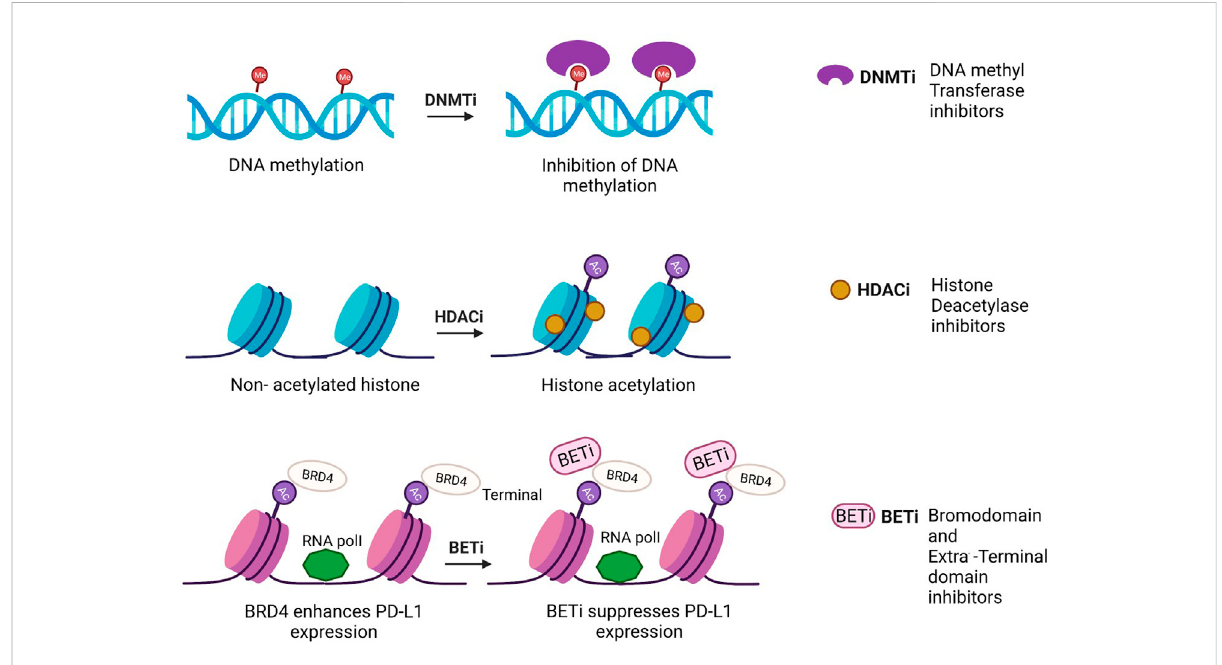
FIGURE 2 Mechanism of action of epidrugs in anticancer therapies [Icons were created by Biorender.com (accessed on February 9th